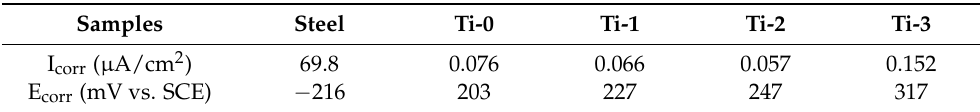
Table 1. Electrochemical parameters of all the samples calculated by potentiodynamic polariza- tion